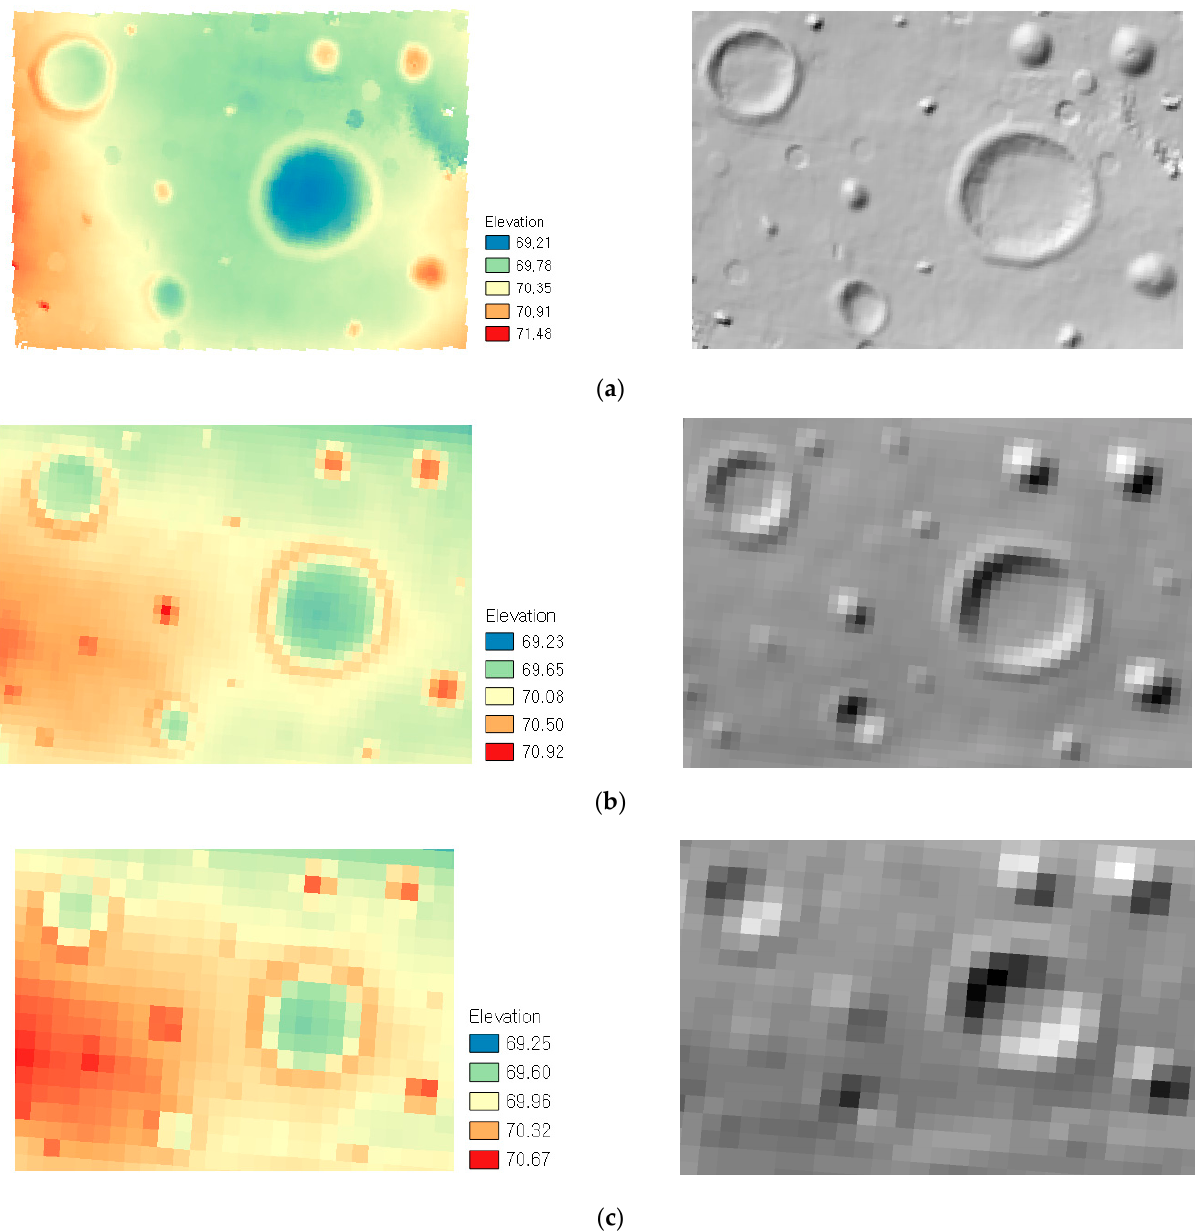
Figure 11. The 3D terrain maps (resolution): ( a ) measured DEM and hillshade (0.3 m); ( b ) emulated DEM and hillshade (1 m); ( c ) emulated DEM and hillshade (2 m).